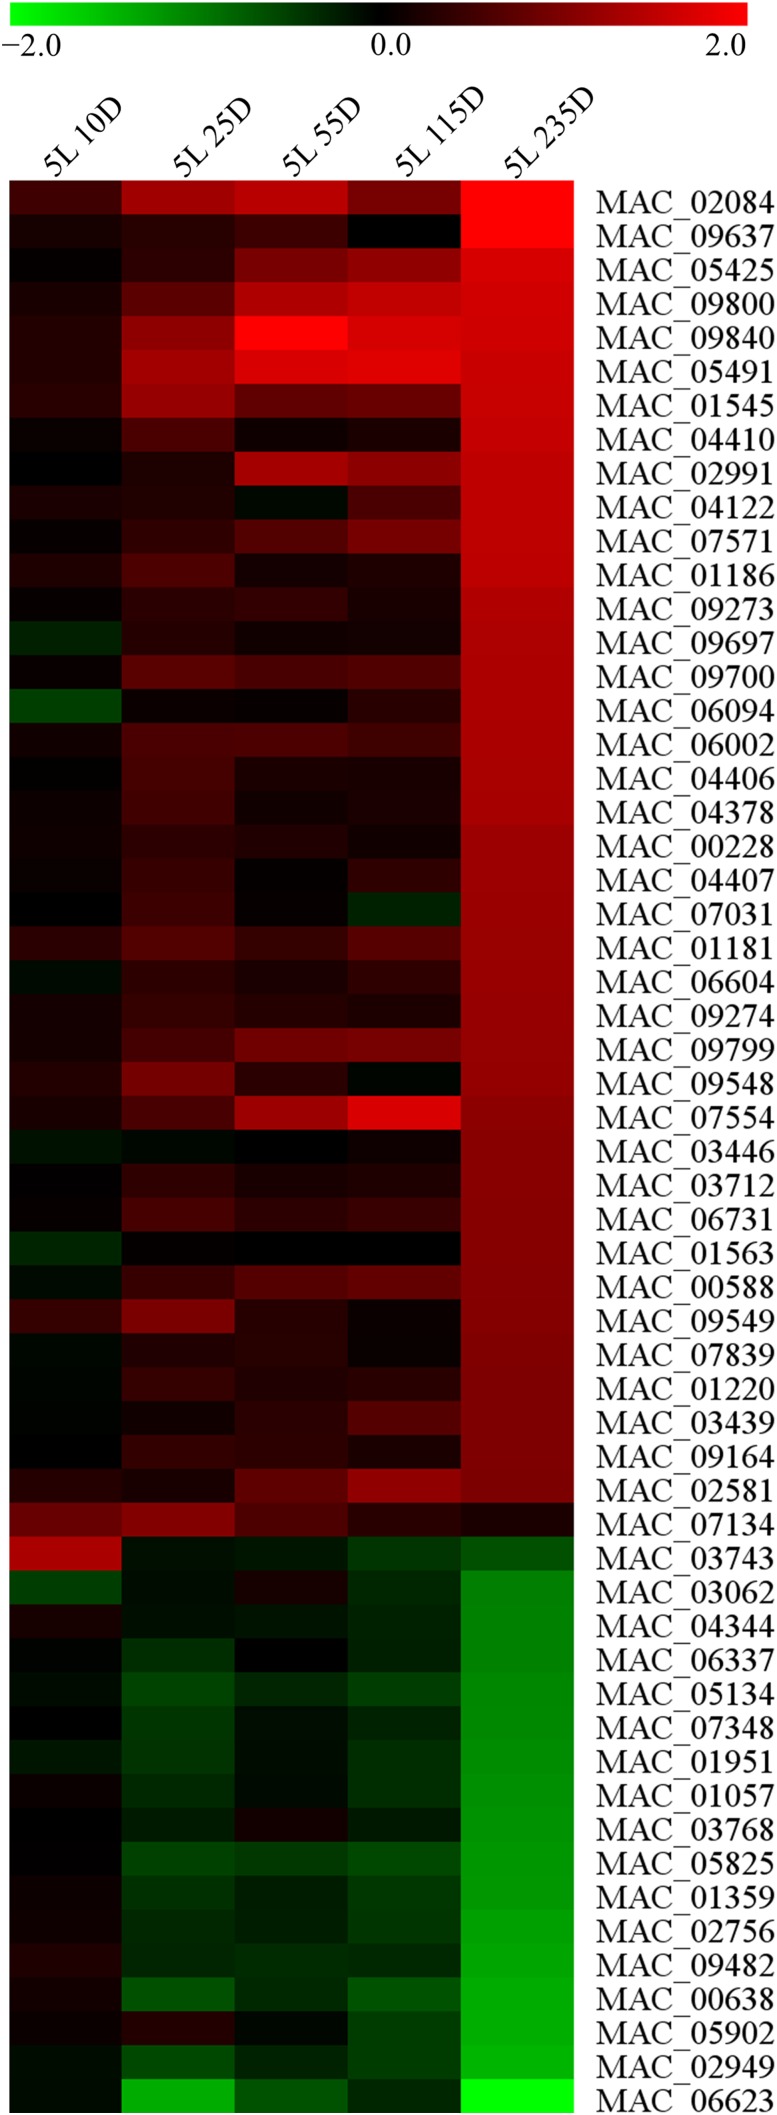
Heat map depicting changes at the protein level after light exposure. Almost 90% of all proteins were regulated at 5L 235D. Values in scale bar are log2 fold-change relative to DD.